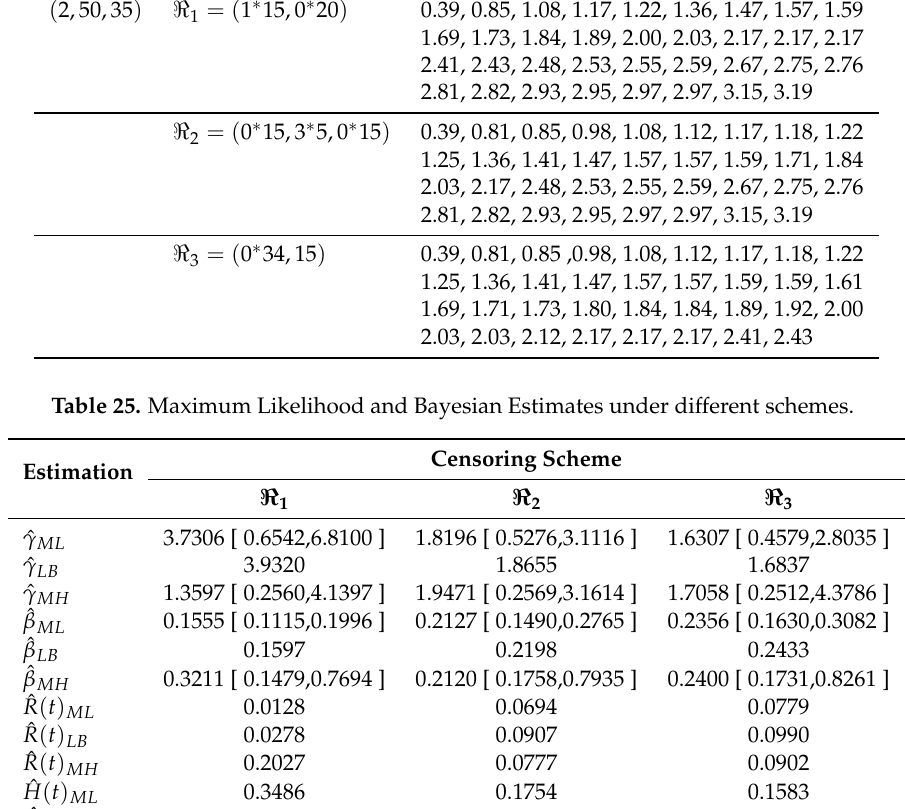
Table 24. The progressive first-failure censored samples generated from the practical data sets. ( k , m , n )